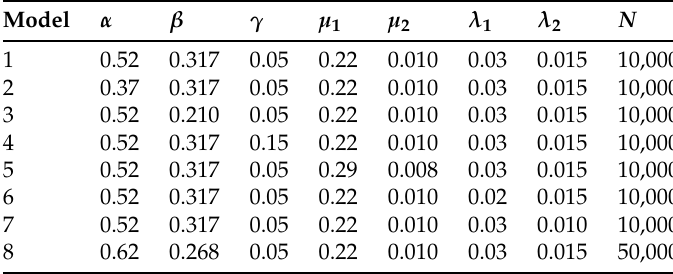
Table 2. Parameters of the